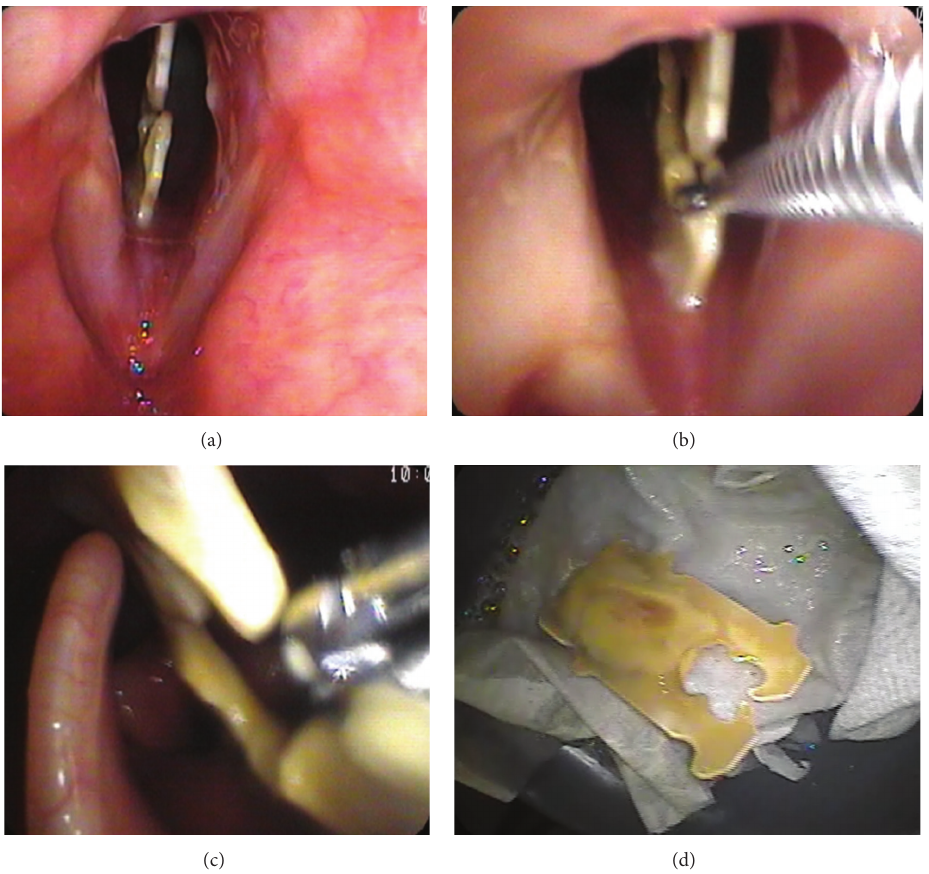
Figure 1: (a) Identification of bread clip wedged into subglottic airway. (b) Using a flexible endoscope with a working channel, a cupped biopsy forceps is introduced into the laryngeal introitus and used to grasp the foreign body. (c) The bread clip is easily withdrawn with the cupped forceps and ultimately removed transorally. (d) The removed foreign body, covered with purulent